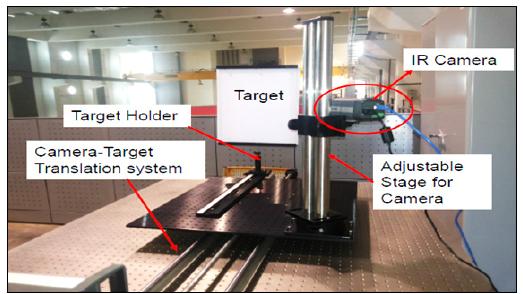
Fig. 22: Mode purity measurements Setup using IR